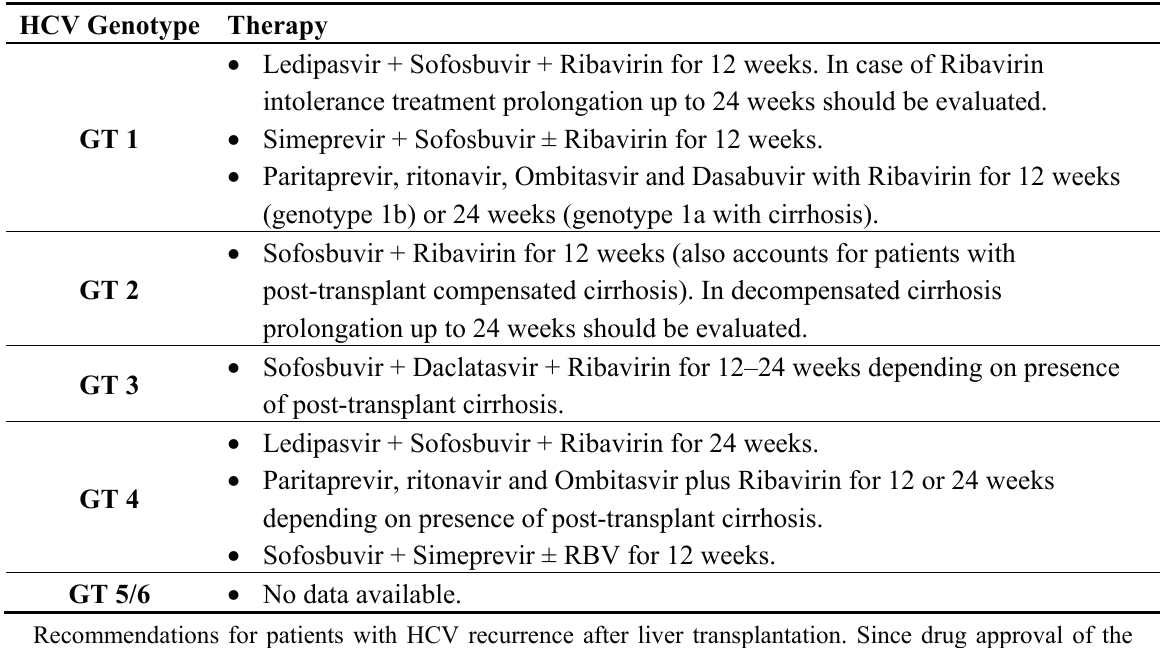
Table 7. Treatment recommendations for HCV recurrence after liver transplantation. HCV